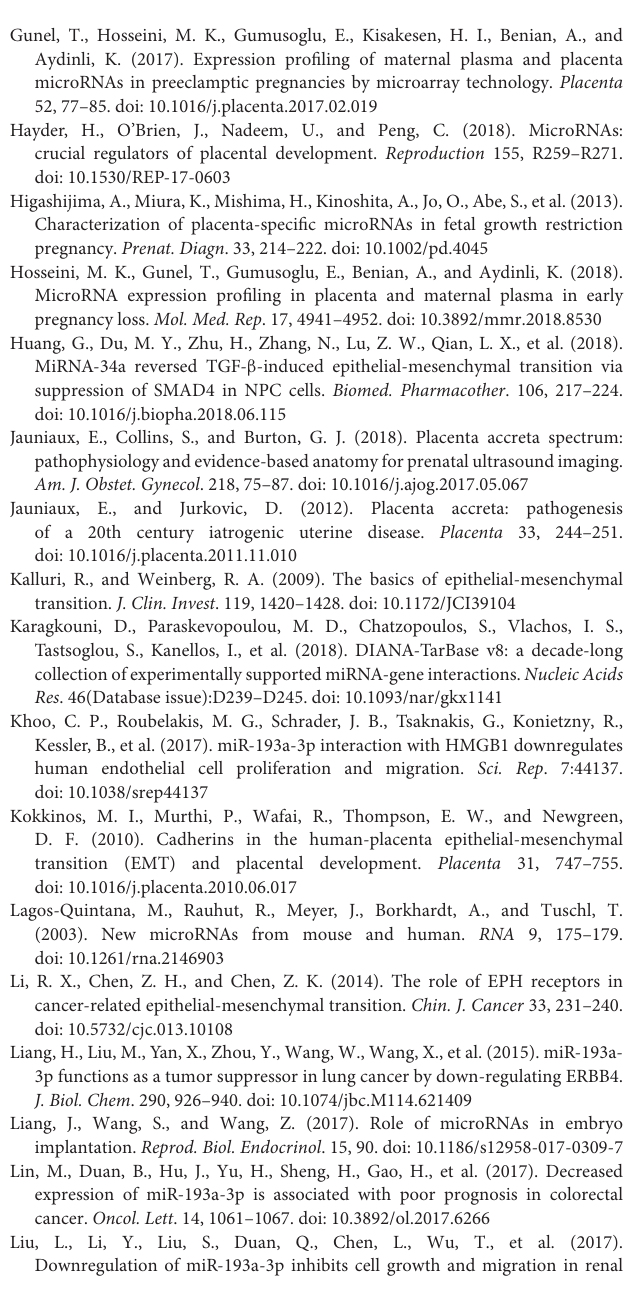
Supplementary Figure 1 | Identification of primary hESCs. (A) Cell morphologies of primary hESCs. (i) indicates × 100 and (ii) indicates × 200. (B) Immunofluorescence staining with anti-vimentin antibody. Red indicates vimentin; blue indicates nuclei stained with DAPI. hESC, human endometrial stromal cell. DAPI,